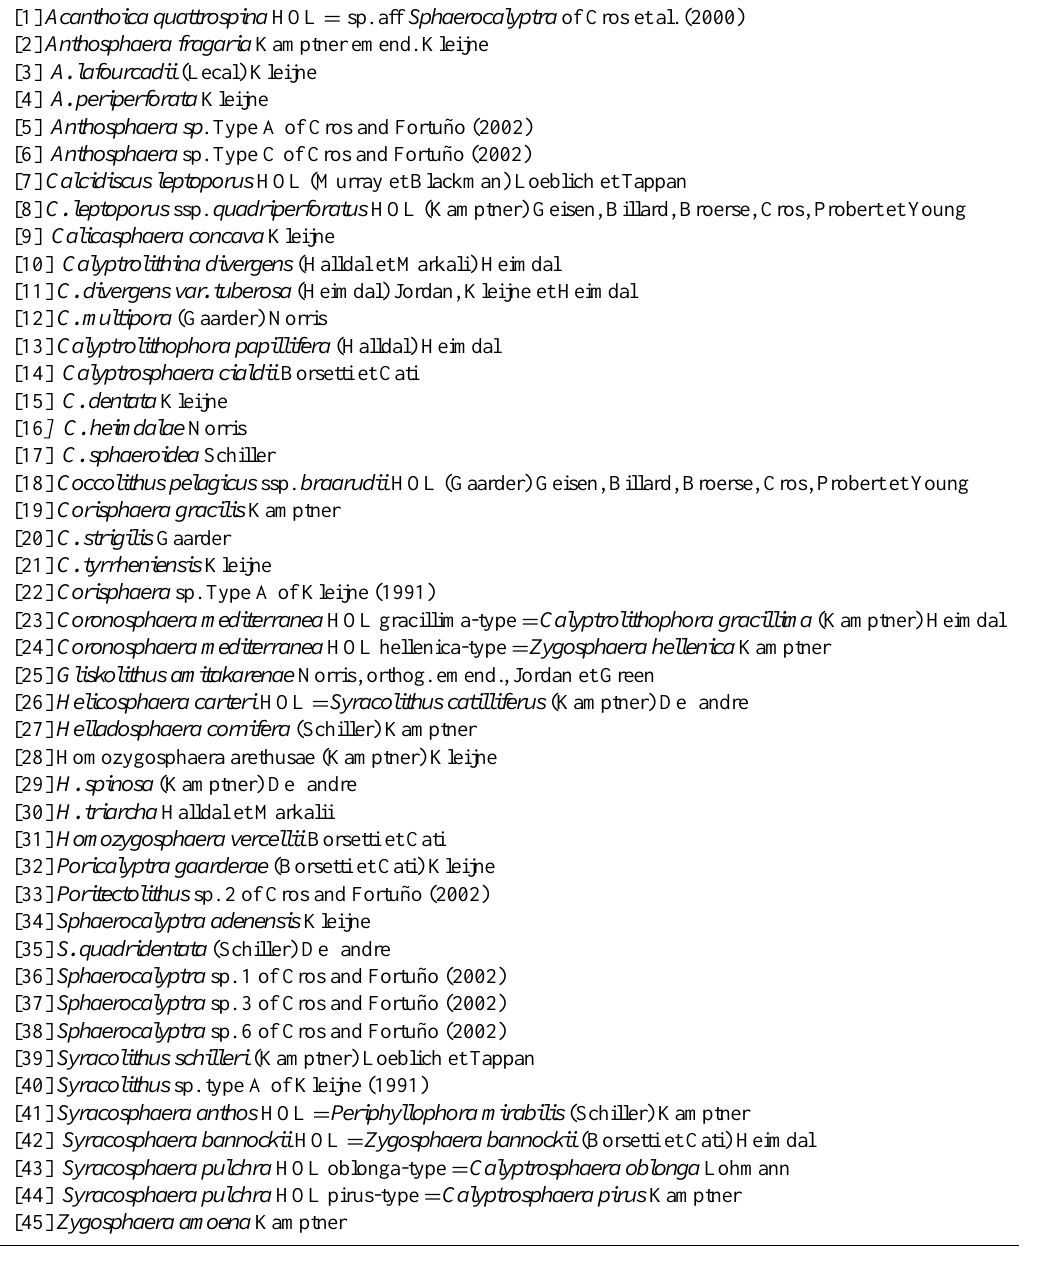
Table A2. Coccolithophore species list.